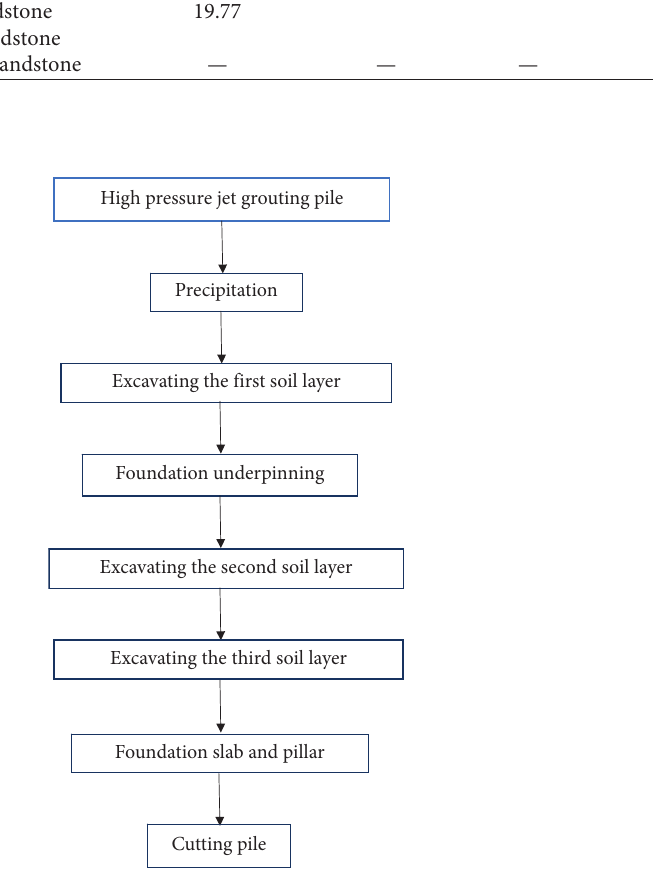
Figure 2: Construction flowchart of No. 3 section basement construction project of Ganshuixiang.